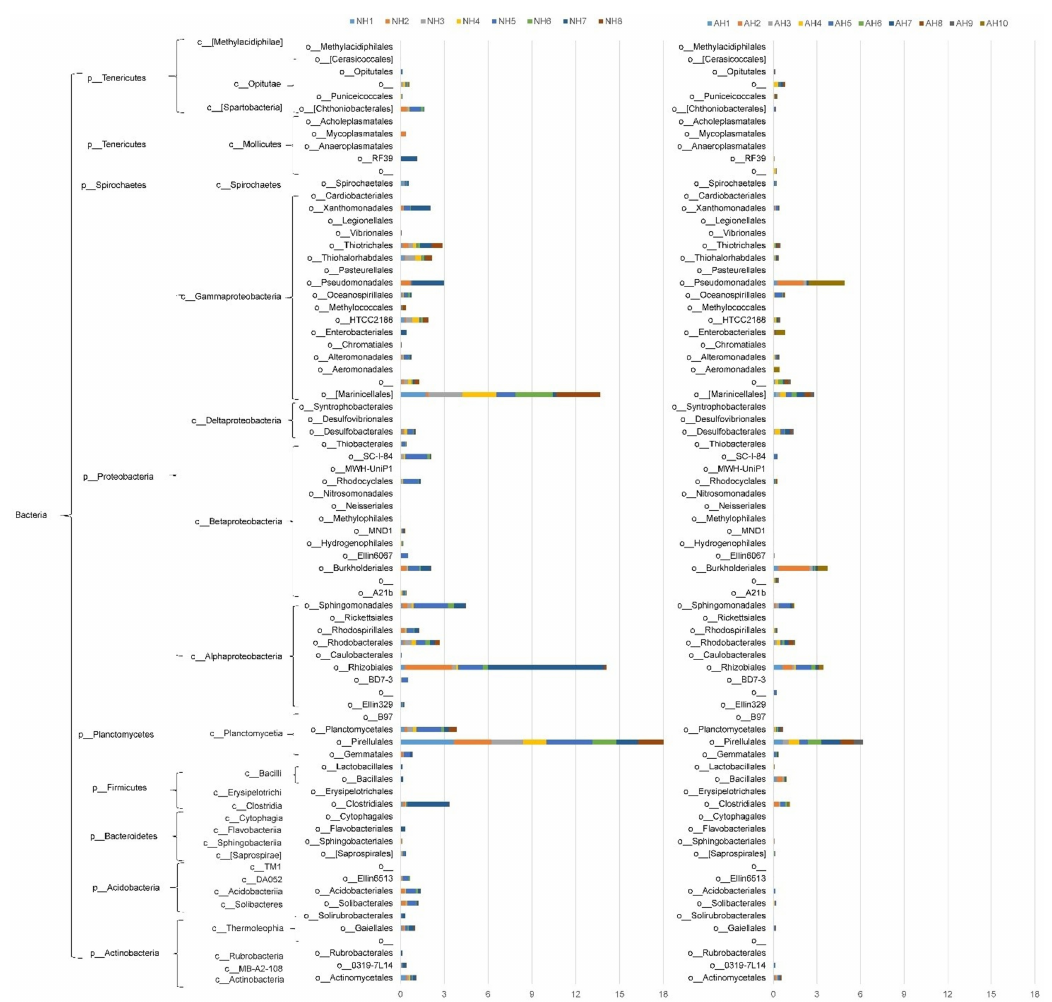
Figure 4. The distribution of azo R genes in diverse groups of